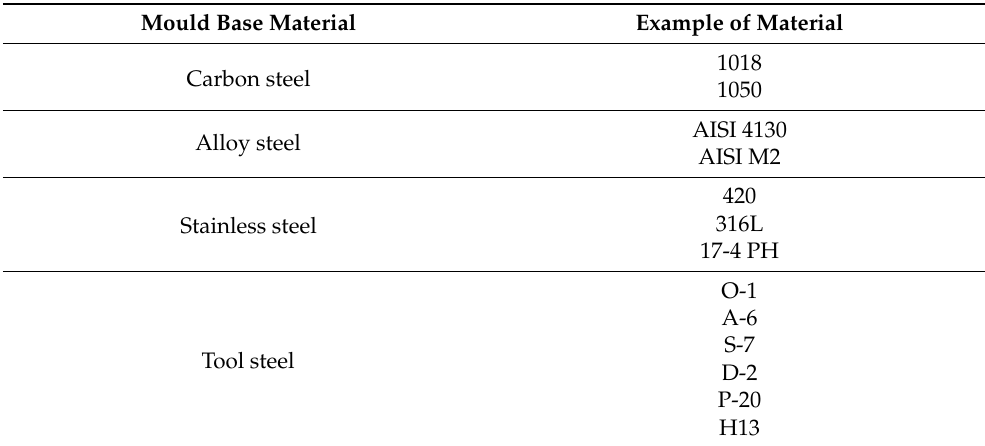
Table 2. Types of mould base material with examples